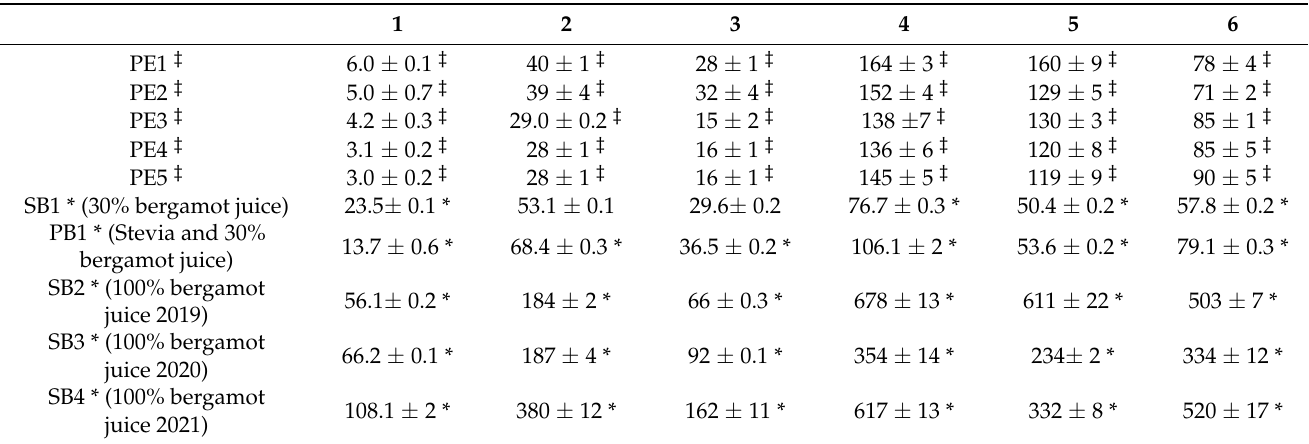
Table 2. Concentrations of the main flavonoids in bergamot samples (PE powder extract, SB sample beverage, PB prototype